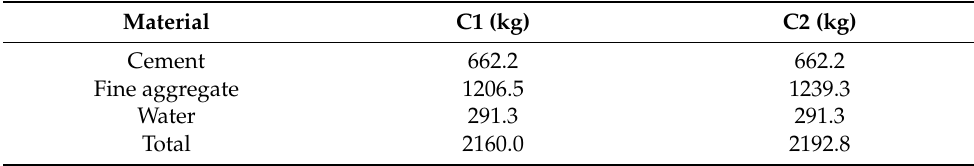
Table 6. Mix dosage to produce 1 m 3 of